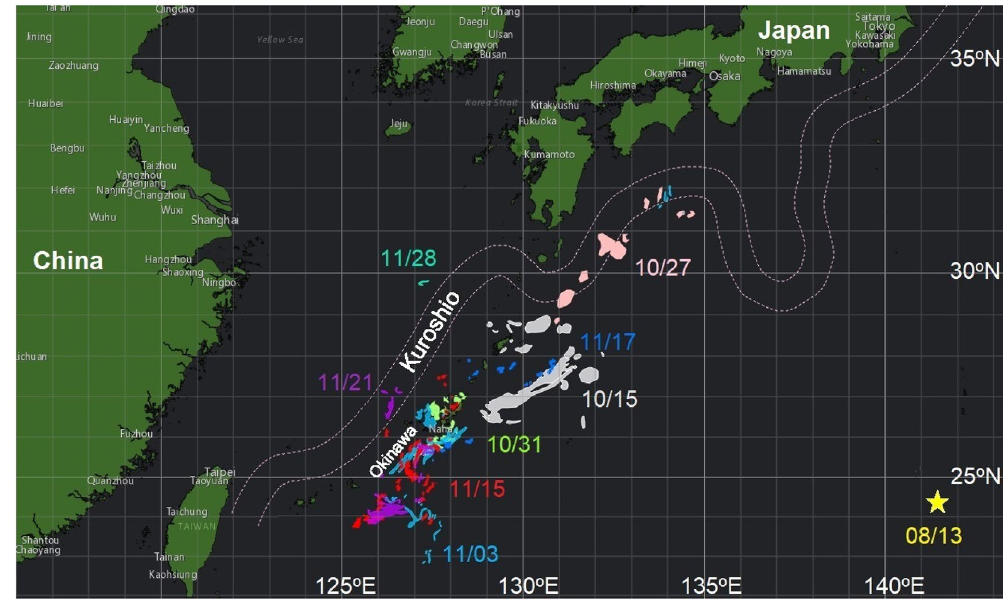
Figure 2. Satellite-observed pumice locations and dates (MM/DD). Different color shadings represent different observation dates; corresponding dates are marked in the same color. Yellow star shows the location of Fukutoku-Oka-no-Ba where the eruption began on 13th August. Continents are shaded dark green. Dashed contours show the mean location of the Kuroshio during the observation period. Pumice locations were observed by satellite GCOM-C (Shikisai) and Sentinel-2, and figure is generated using ArcGIS online system (https:// www. esrij. com/ produ cts/ arcgis-